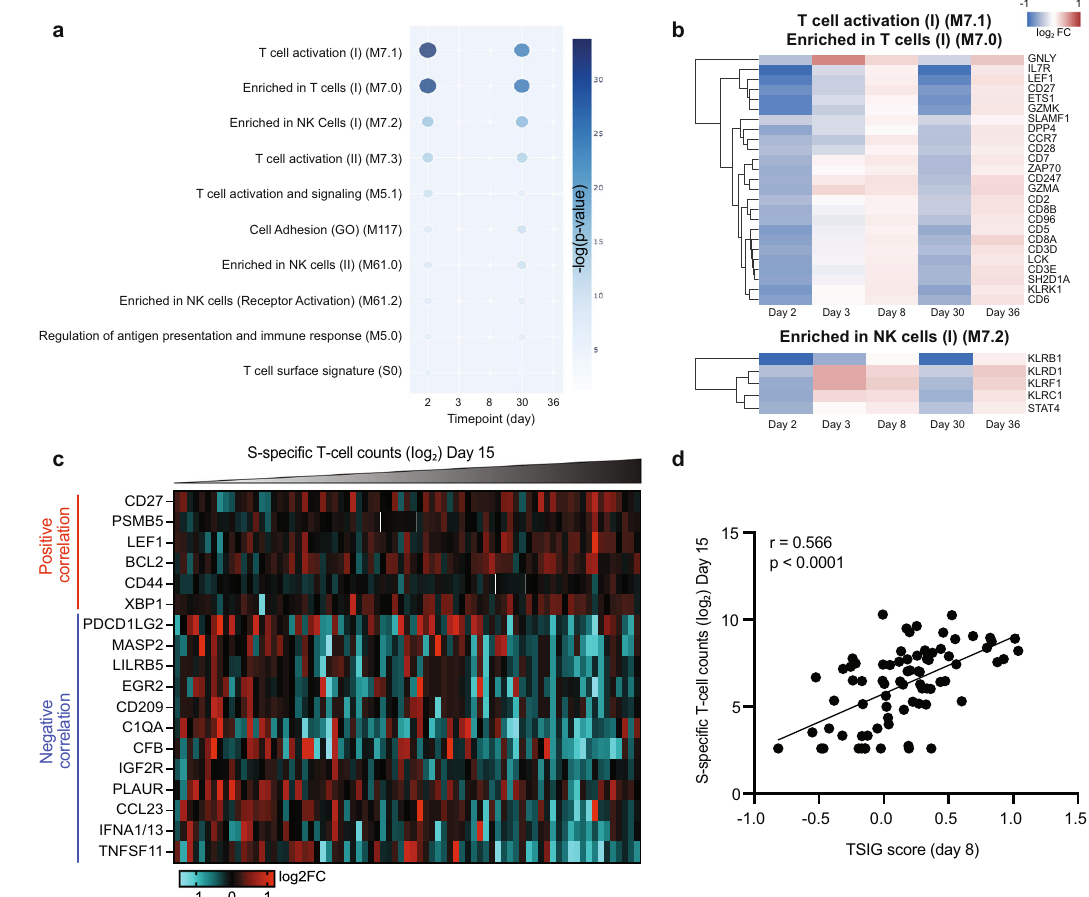
Fig. 3 Transcriptional correlates of spike-speci fi c T cell responses are observed at day 7. a Top 10 blood transcription modules (BTMs) that are negatively enriched (Benjamini-Hochberg adjusted p -value < 0.05) at day 2, 3, 8, 30 and 36 in vaccinated subjects compared to placebo controls. Colour intensity and size of the dots are proportional to the − log10 transformed Benjamini-Hochberg adjusted p -values. b Clustergram showing the log2-transformed fold-change of DEGs present in the top BTM modules highlighted in, “ T-cell activation (I) (M7.1) ” , “ Enriched in T cells (I) (M7.0) ” and “ Enriched in NK cells (I) (M7.2) ” at day 2, 3, 8, 30 and 36. The colour-gradient from blue to red indicates log2- transformed fold change (day 2/day 1) values from − 1 to 1 respectively. c Heatmap showing day 8 transcripts that are signi fi cantly correlated ( p -value < 0.05) with log2-transformed S-speci fi c T cell counts at day 15 in ARCT-021 vaccinated individuals. Transcripts are ranked by Pearson correlation coef fi cient values. d . Pearson correlation of log2-transformed S-speci fi c T cell counts at day 15 with TSIG score. TSIG score for each sample was calculated by subtracting the arithmetic log2 fold change values of the 12 negatively correlated genes from the 6 positively correlated genes shown in panel peptide degradation and processing, peptide loading and MHC class I, which can in turn promote CD8 T-cell survival and responses 29 . Two possible reasons may account for why T-cell signatures were more apparent at a later time point. One possibility is that the early migration of T-cells from peripheral blood to lymph nodes may have masked the T-cell proliferation, activation and maturation signatures, which was also observed in SARS-CoV-2 infected individuals 30,31 and in individuals who received the in fl uenza vaccine 32 . The other possibility is a lag phase between ARCT-021 vaccination and induction of T-cell signatures. Indeed, T-cell signatures in live-attenuated vaccines (YF17D, LAIV) 8,24 , MRKAd5/HIV 33 and adjuvanted vaccines 34 were only induced 3 days after vaccination. Moreover, memory CD8 T-cells have been shown to reside primarily in the lymphoid organs 35 , which may have hindered the detection of transcripts related to T-cell memory. Future studies that evaluate gene expression in tonsils or lymph nodes after sa-mRNA vaccination could thus be insightful. Although the early transcriptomic signatures of BNT162b2 and ARCT-021 were largely similar after the fi rst dose, an interesting